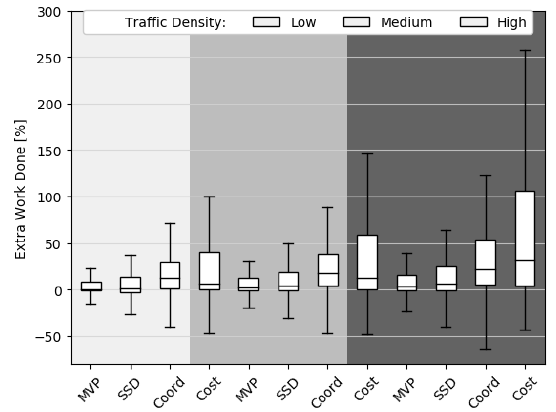
Figure 18. Extra work done per flight and per CD&R method for manned